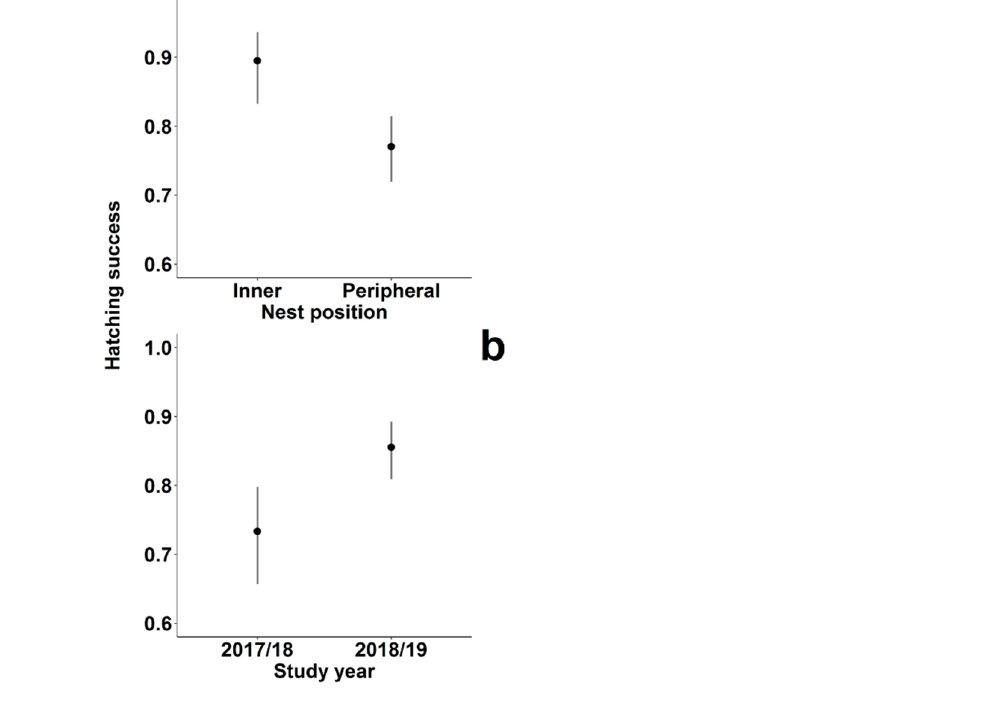
Figure 6. Effects of ( a ) nest position and ( b ) study year on the hatching success of Adélie penguins predicted by GLMs. Black dots: predicted values. Grey bars: 95% confidence intervals.